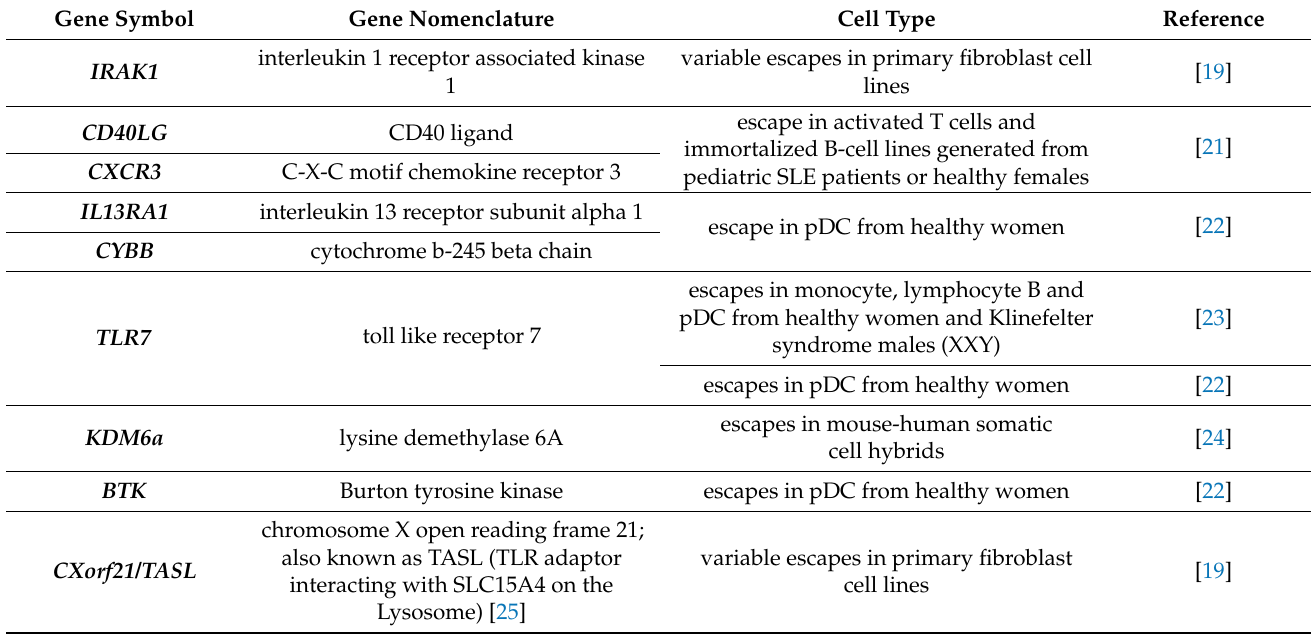
Table 1. Genes that escape from XCI in immune